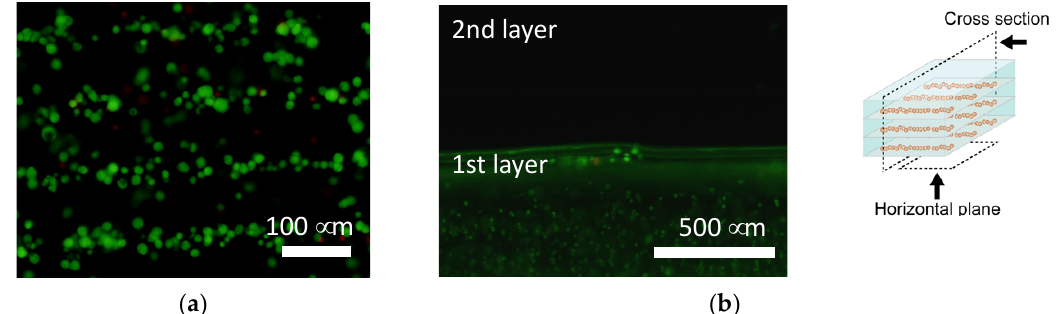
Figure 10. Calcein-AM staining of the agarose gel-sheet constructs cultured for 7 days. Fluorescence images captured from ( a ) the horizontal plane and ( b ) the cross section.